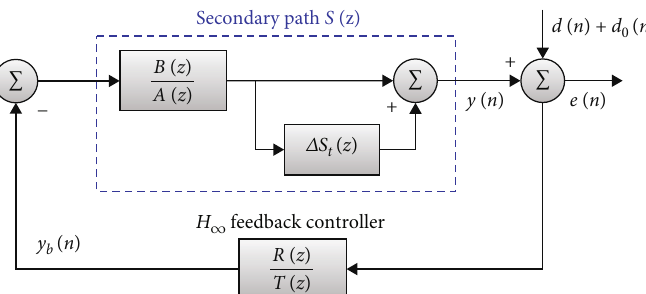
S ð z Þ based on multiplicative